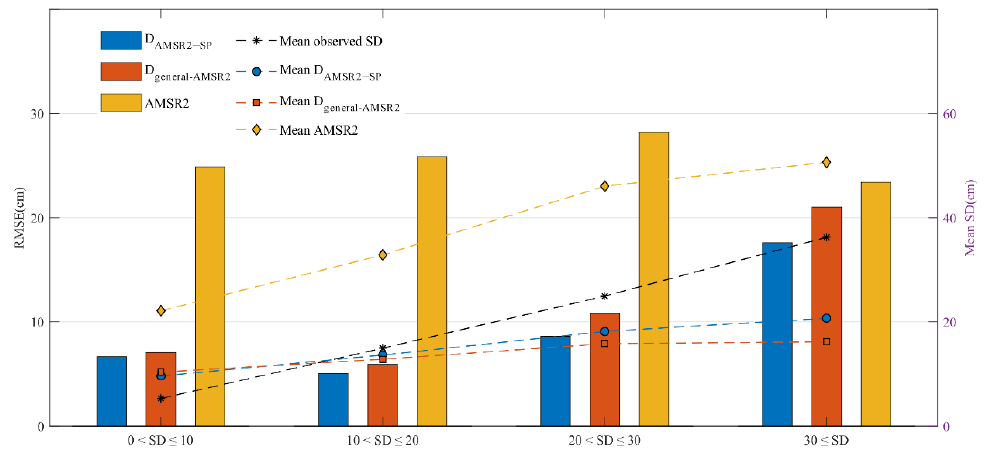
Figure 9. Statistical analysis results of the RMSE of the multifactor SD downscaling model based on the observed SD at ground meteorological stations. The corresponding dashed lines represent mean SD.